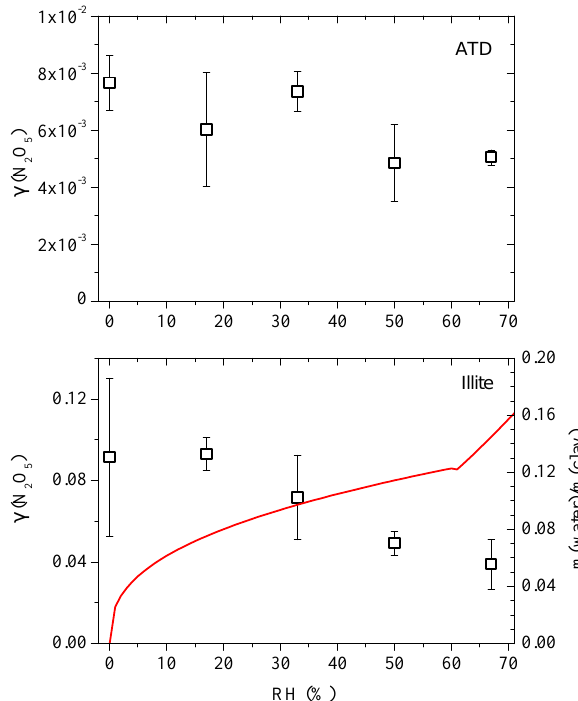
Fig. 6. Uptake coefficients of N 2 O 5 at different relative humidities to illite and ATD. The ratio of the mass of absorbed water to that of dry illite (lower panel, red curve, right y axis) is also plotted as a function of RH (Hatch et al., 2012).